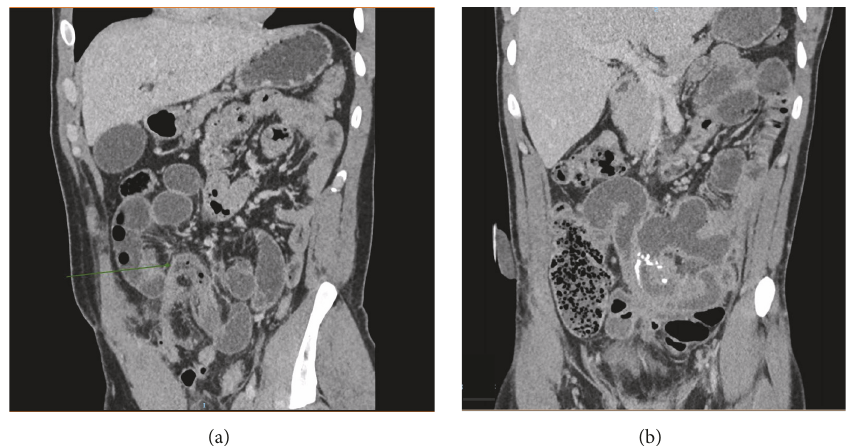
Figure 2: ((a) and (b)) Contrast enhanced coronal CT images 5 days after trauma: there is small bowel dilatation with an acute calibre change of the small bowel indicating obstruction at the position of the previous mesenteric haematoma (arrow in (a)).